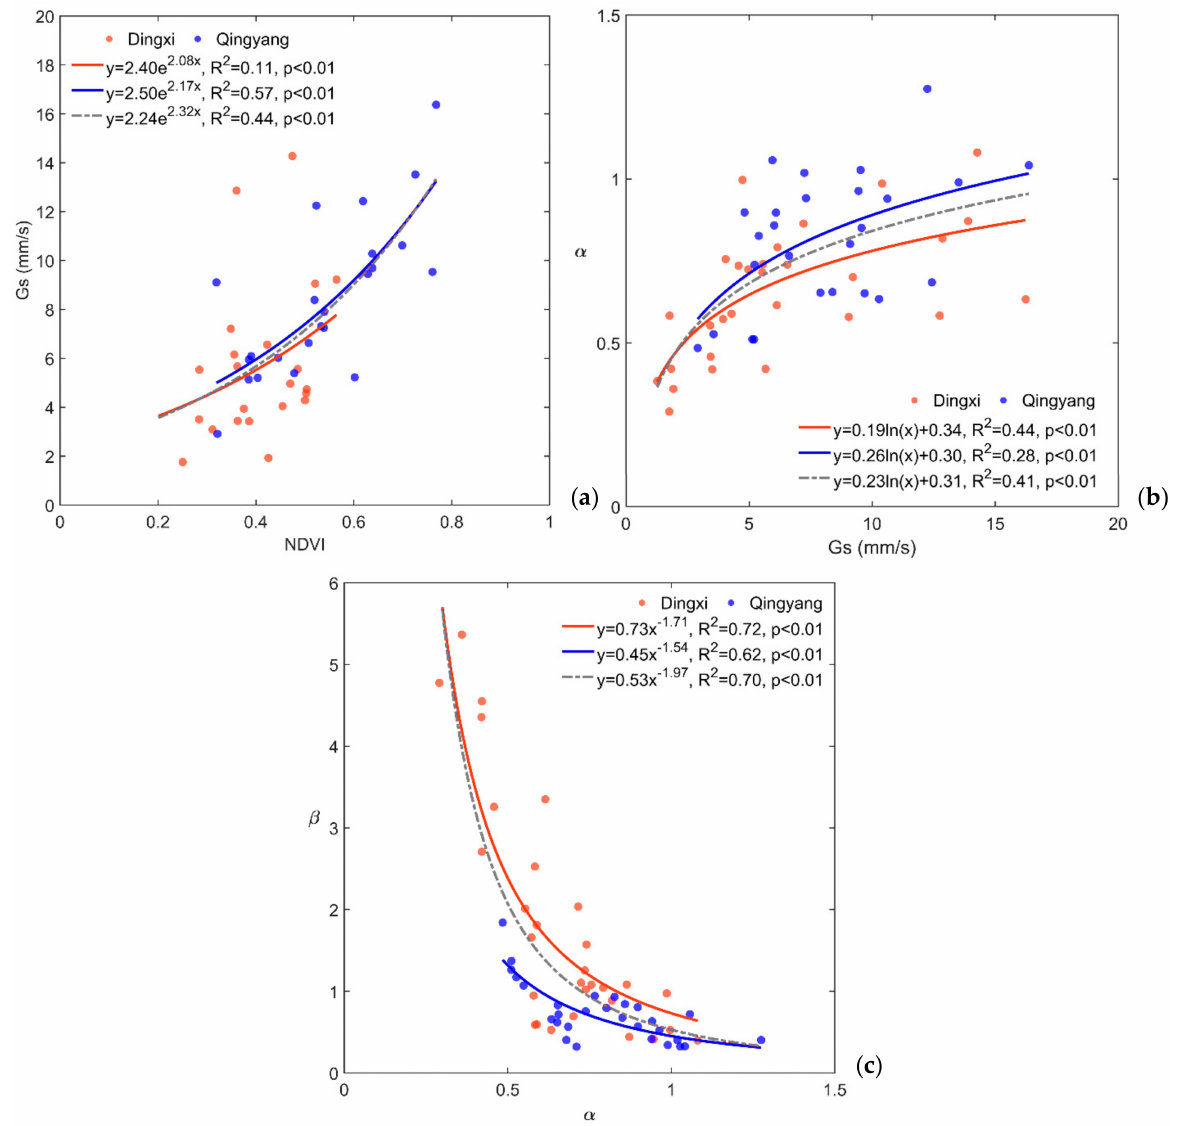
Figure 11. Relationship between ( a ) the NDVI and Gs , ( b ) Gs and α , ( c ) α and β on a monthly scale. We produced path diagrams of the Dingxi and Qingyang stations to further analyze the direct and indirect effects of various influencing factors on β (Table 6). On a daily scale, eco-environmental factors at Dingxi and Qingyang explained 60% and 58% of the change in β , respectively. From an impact factor perspective, β in the semi-arid area was primarily influenced by the direct effect of NDVI and the indirect effect of SWC (path coefficients of − 0.68 and − 0.41, respectively). Ta and NDVI in the semi-humid area